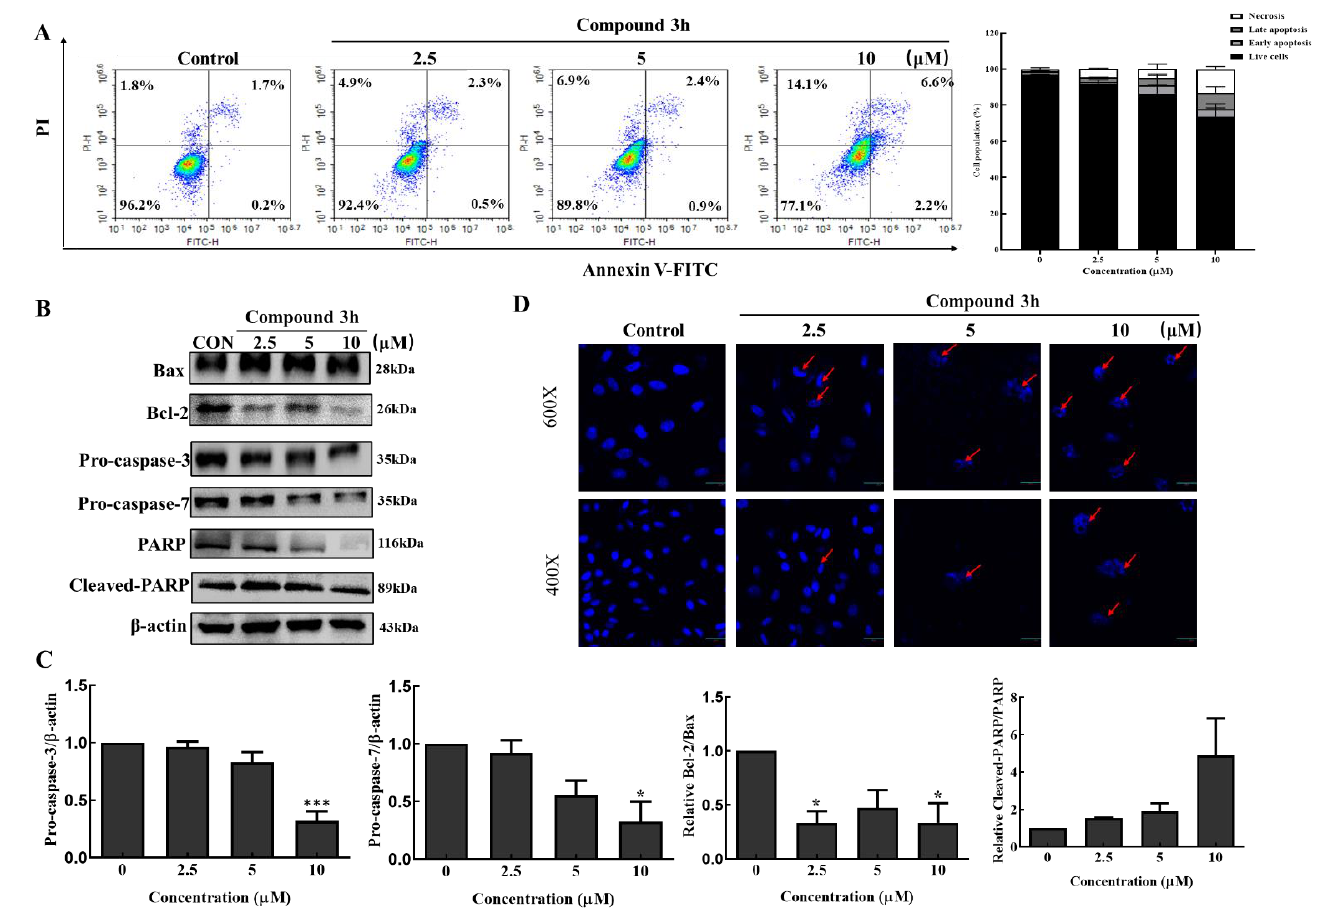
Figure 6. Compound 3h induces LNCaP cellular apoptotic cell death. ( A ) Compound 3h caused apoptosis in LNCaP cells. Late apoptosis and necrosis percentage increased in the compound 3h - treated group. ( B ) Effect of compound 3h on the expression levels of apoptotic proteins. Compound 3h induced apoptotic proteins expression. ( C ) Quantitative data of apoptotic proteins. ( D ) Nuclear morphological changes and apoptotic bodies were detected in the compound 3h -treated group. The values represent the mean ± SD. * p < 0.05, and *** p < 0.001. The uncropped blots are shown Supplementary Material.